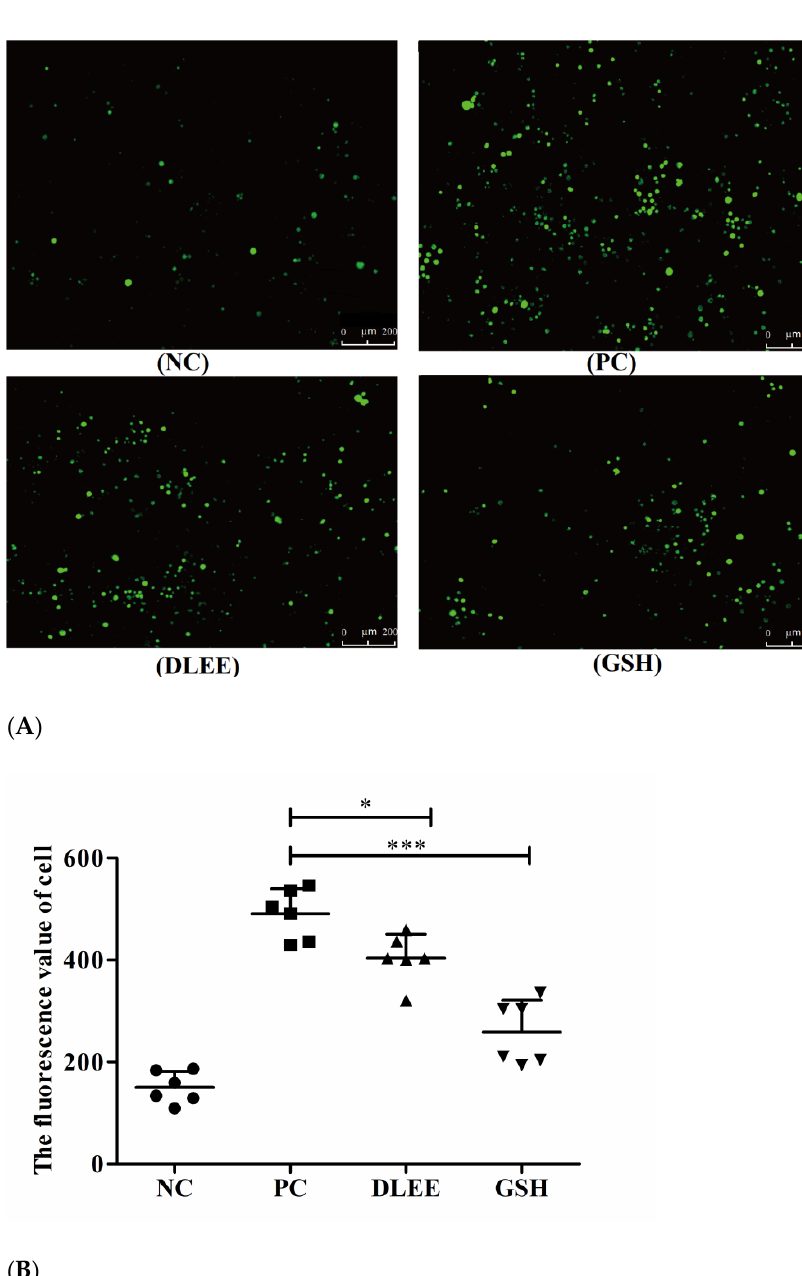
Figure 2. ( A ) A Fluorescence micrograph of Caco-2 cells (50×) following treatment with DLEE and GSH. ( B ) The fluorescence values of cells. NC, Caco-2 cells without H 2 O 2 ; PC, H 2 O 2 -induced cells; DLEE and GSH were administered at a concentration of 1.0 mg/mL to H 2 O 2 -induced cells. Data are presented as the means ± SD ( n = 6); * shows the significant differences of p < 0.05 and *** shows the significant differences of p < 0.001 with the unpaired t -test.